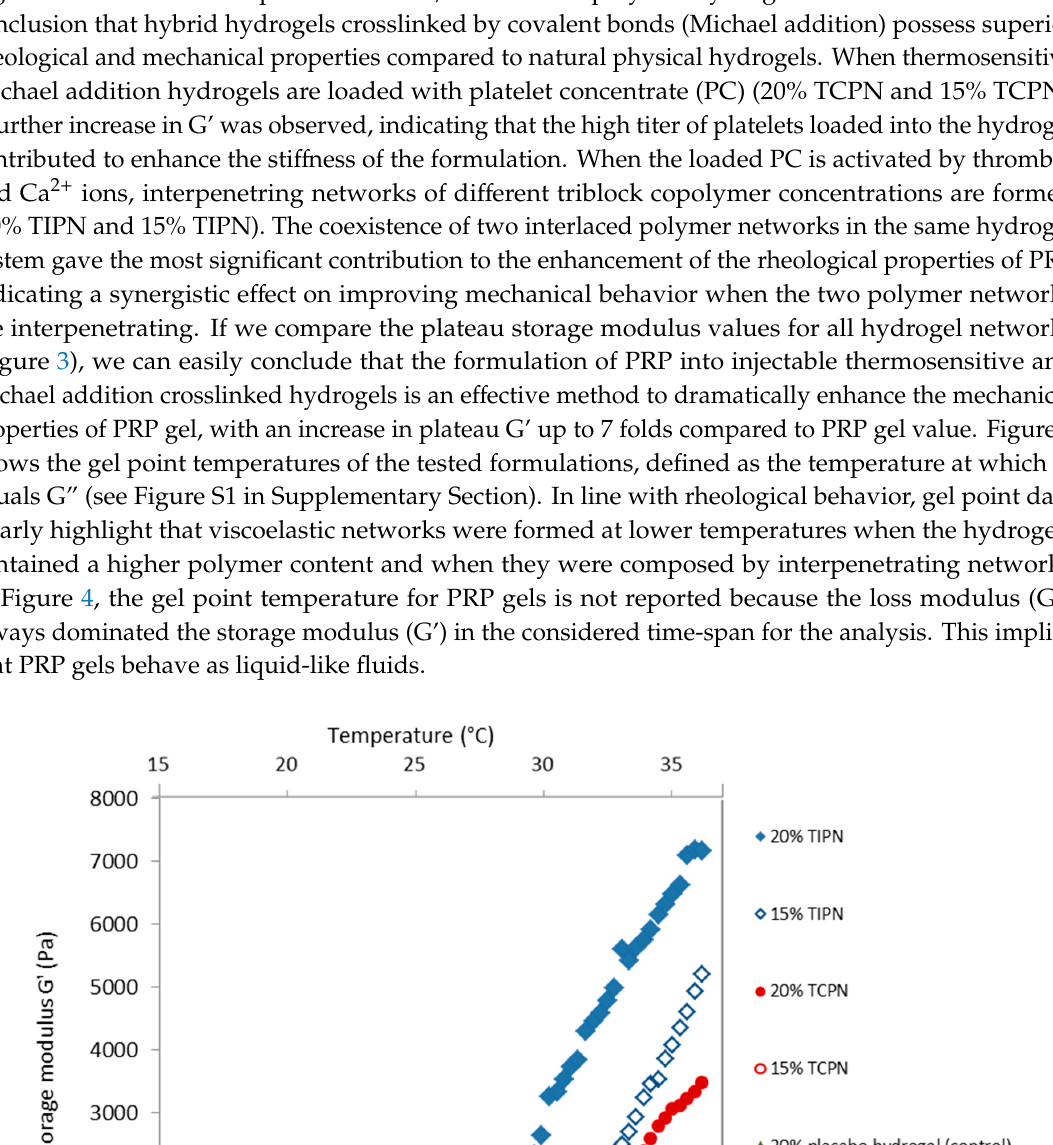
Figure 3. Comparison of plateau storage (G’) moduli for different hydrogel formulations.